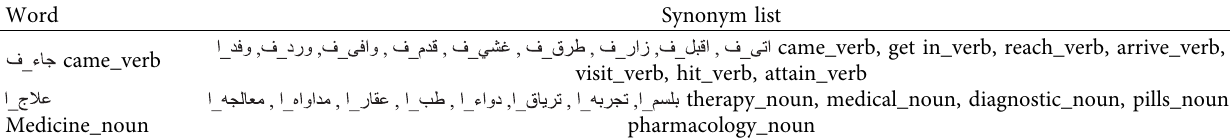
Table 7: Sample of the synonym lexicon for the POS-tagged corpus.